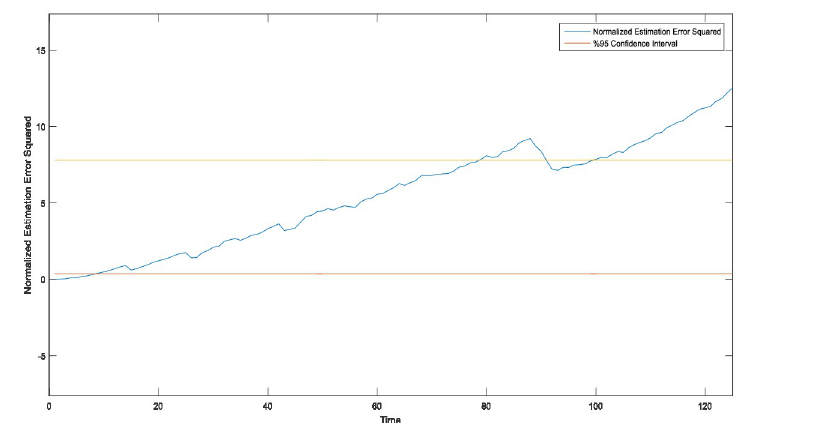
Fig 13. PFF based A-SLAM normalized estimation error.